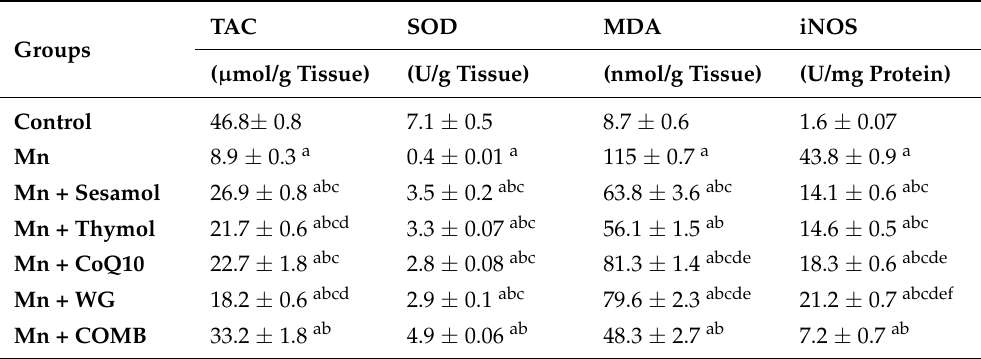
Table 3. Effect of sesamol, thymol, CoQ10, WG, or their combination on MnCl 2 -induced changes in brain redox